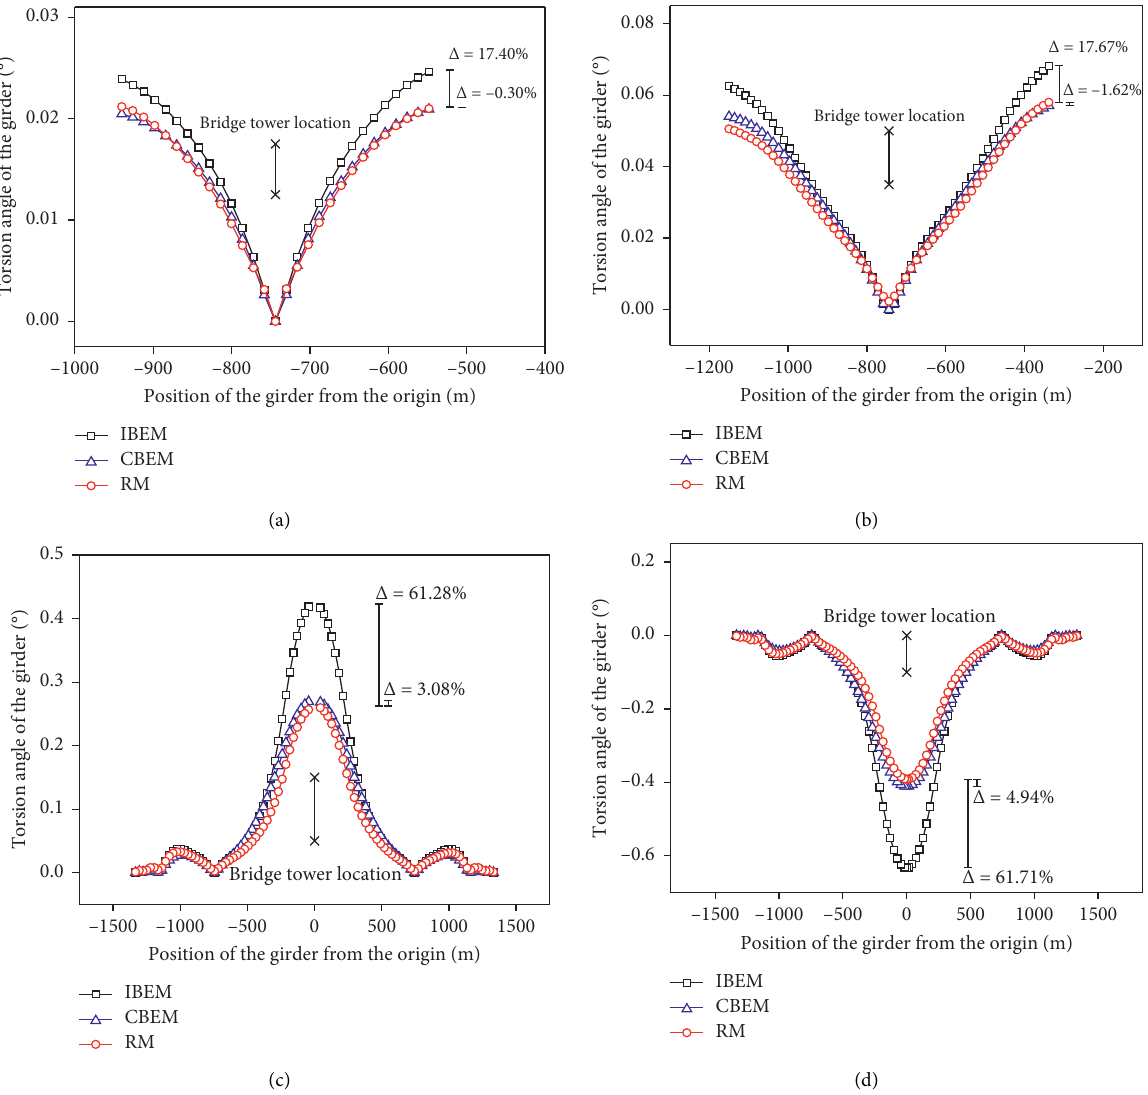
Figure 8: Comparison diagram of torsional angle of the girder in different states. (a) The common double-cantilever state. (b) The maximum double-cantilever state. (c) The preclosure states. (d) The finished state. And Δ � ( calculation valueof IBEM ( CBEM )− calculation valueof RM/calculationvalue of RM ) ×